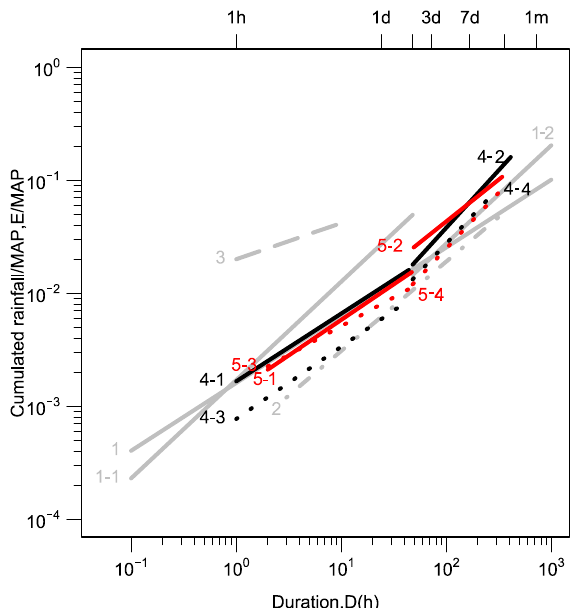
Figure 6. Comparison between the EMAP–D thresholds defined in this study and previous published thresholds. The numbers refer to No. in Table 4.